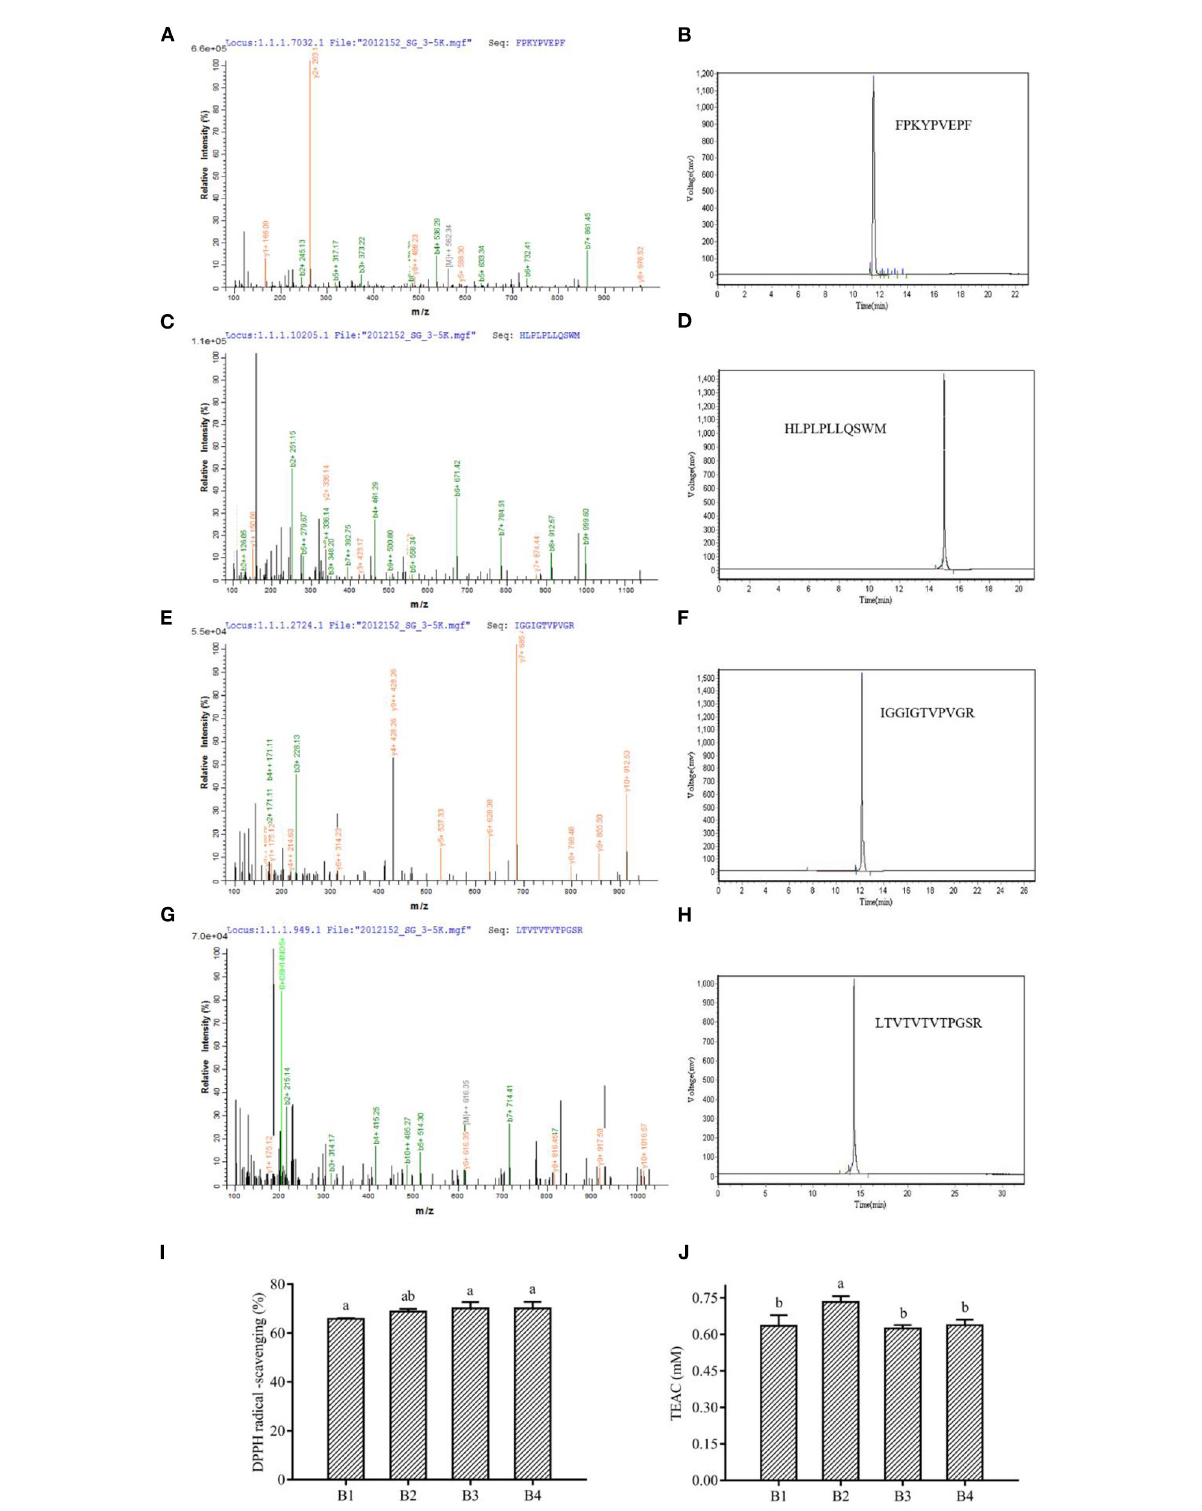
FIGURE4 Mass spectrum and the primary structure of the peptide (A) FPKYPVEPF, (C) HLPLPLLQSWM, (E) IGGIGTVPVGR, and (G) LTVTVTVTPGSR. HPLC of synthetic peptides FPKYPVEPF (B) , HLPLPLLQSWM (D) , IGGIGTVPVGR (F) , and LTVTVTVTPGSR (H) . The DPPH radical scavenging ability (I) and TEAC (J) of peptides. B1, peptide FPKYPVEPF. B2, peptide HLPLPLLQSWM. B3, peptide IGGIGTVPVGR. B4, peptide LTVTVTVTPGSR. Different lowercase letters indicate significant differences between groups ( p <